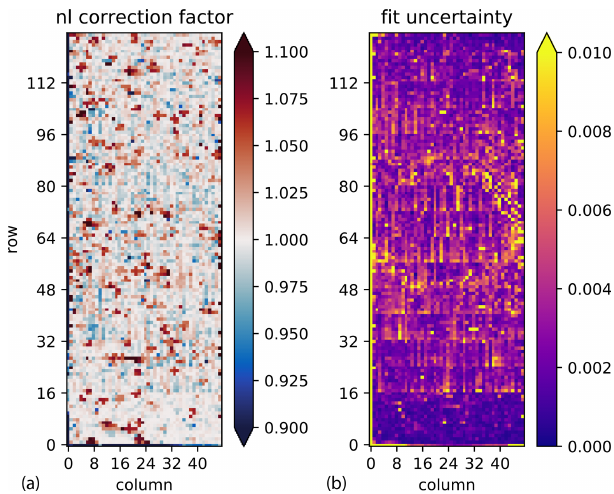
Figure 3. The correction factors for blackbody raw spectra derived for a blackbody–deep space calibration sequence of WISE cam- paign/flight 16. Panel (a) : the correction factors. Panel (b) : the un- certainties derived from the least squares fit.